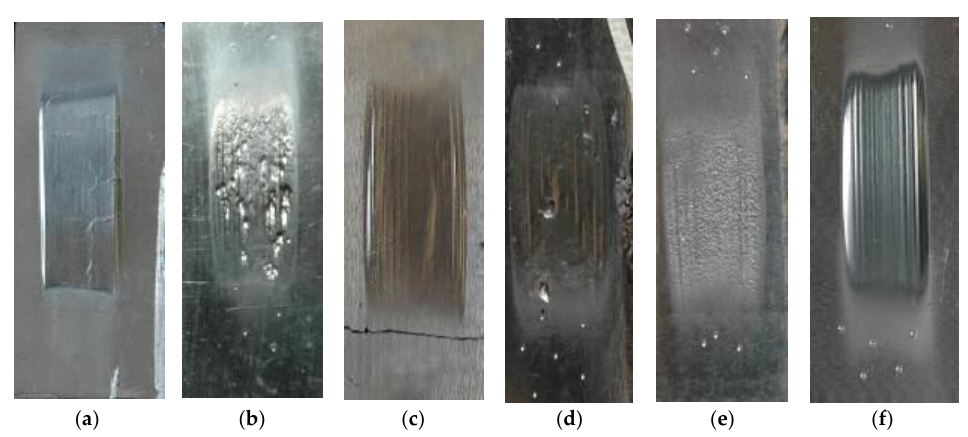
Figure 5. Abrasion tests samples following the abrasion test: ( a ) NANO; ( b ) ABRECOPLATE; ( c ) CDP; ( d ) ABRADUR 64; ( e ) WC; ( f ) HARDOX 400.